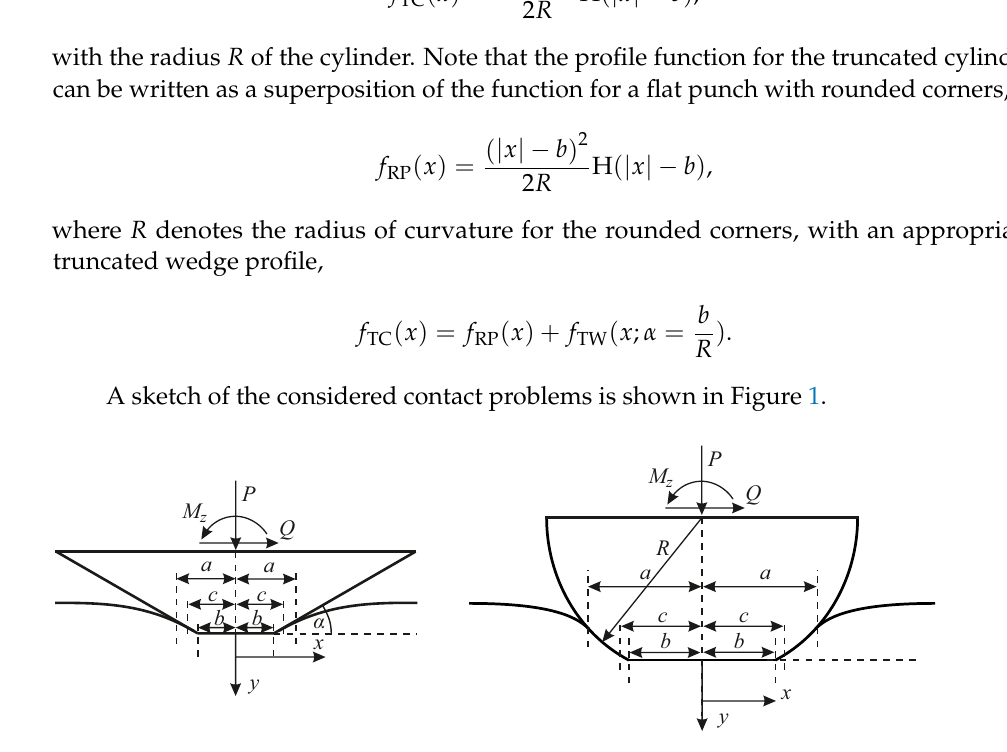
Figure 1. Tangential contact with an elastic half-plane for a rigid truncated shallow wedge ( left ) and a rigid truncated cylinder ( right ); a is the half-width of the contact, c is the half-width of the stick